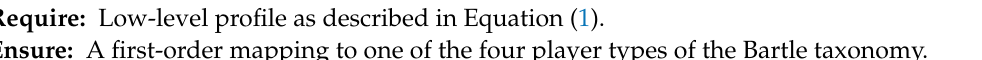
Algorithm 1 Mapping of low-level attributes to Bartle taxonomy.